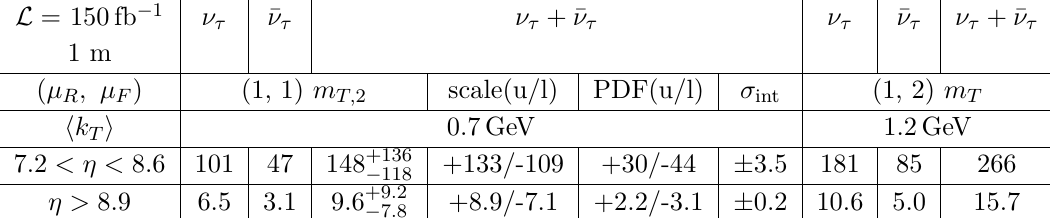
mesons produced in pp collisions s